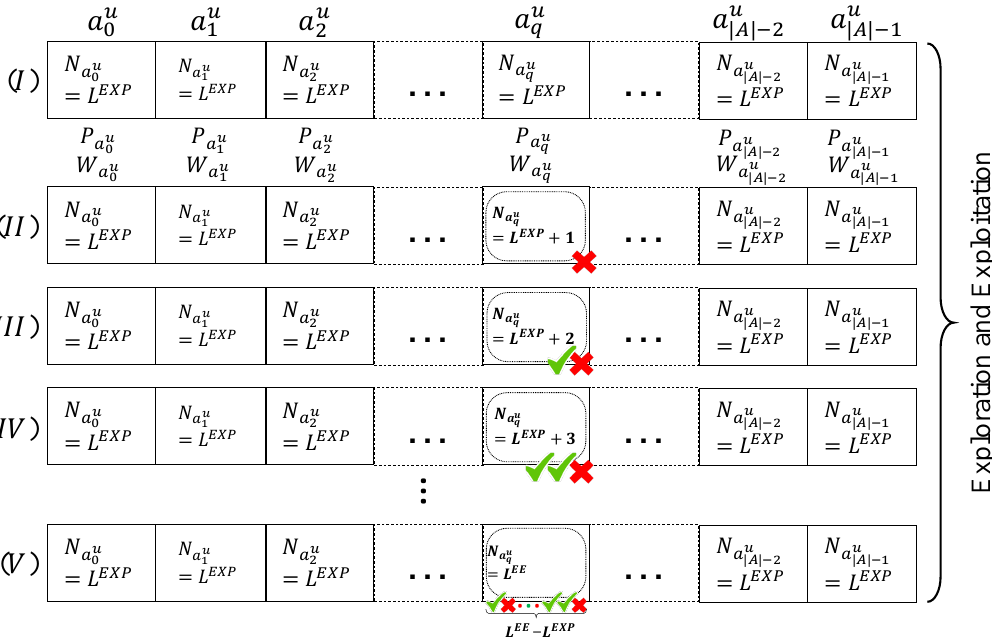
Figure 7. Possible LP-MAB exploitation phase for the u th ED, with ( V ) representing the final round of the exploitation phase for this transmission period of the u th ED. In this extreme case used as an example, action a u q has been selected to be performed in all